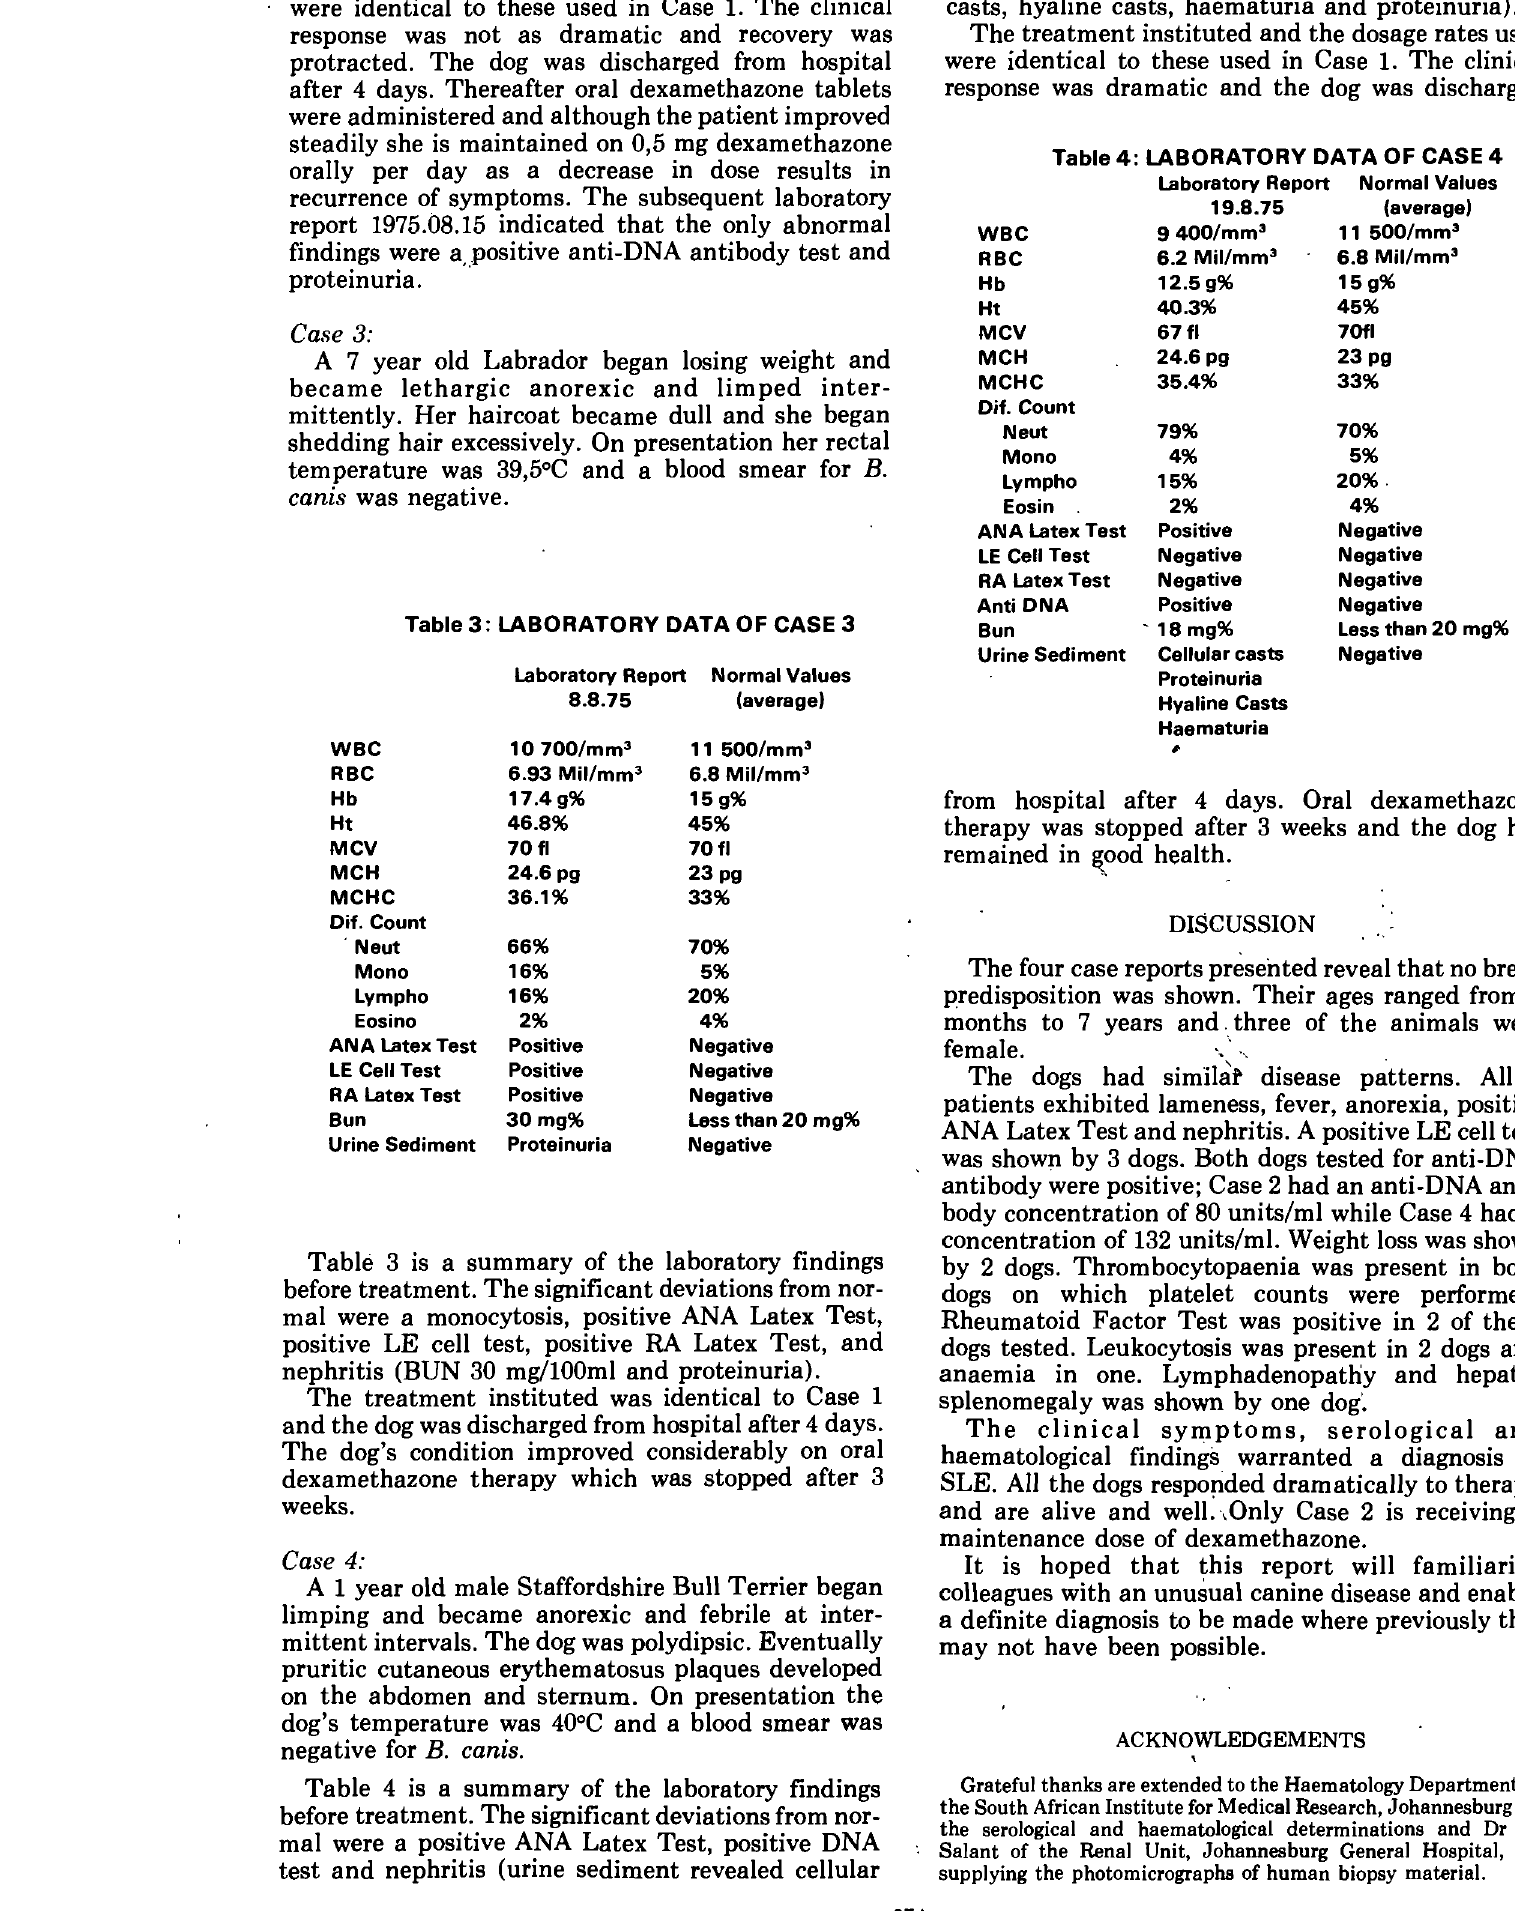
Table 3: LABORATORY DATA OF CASE 3